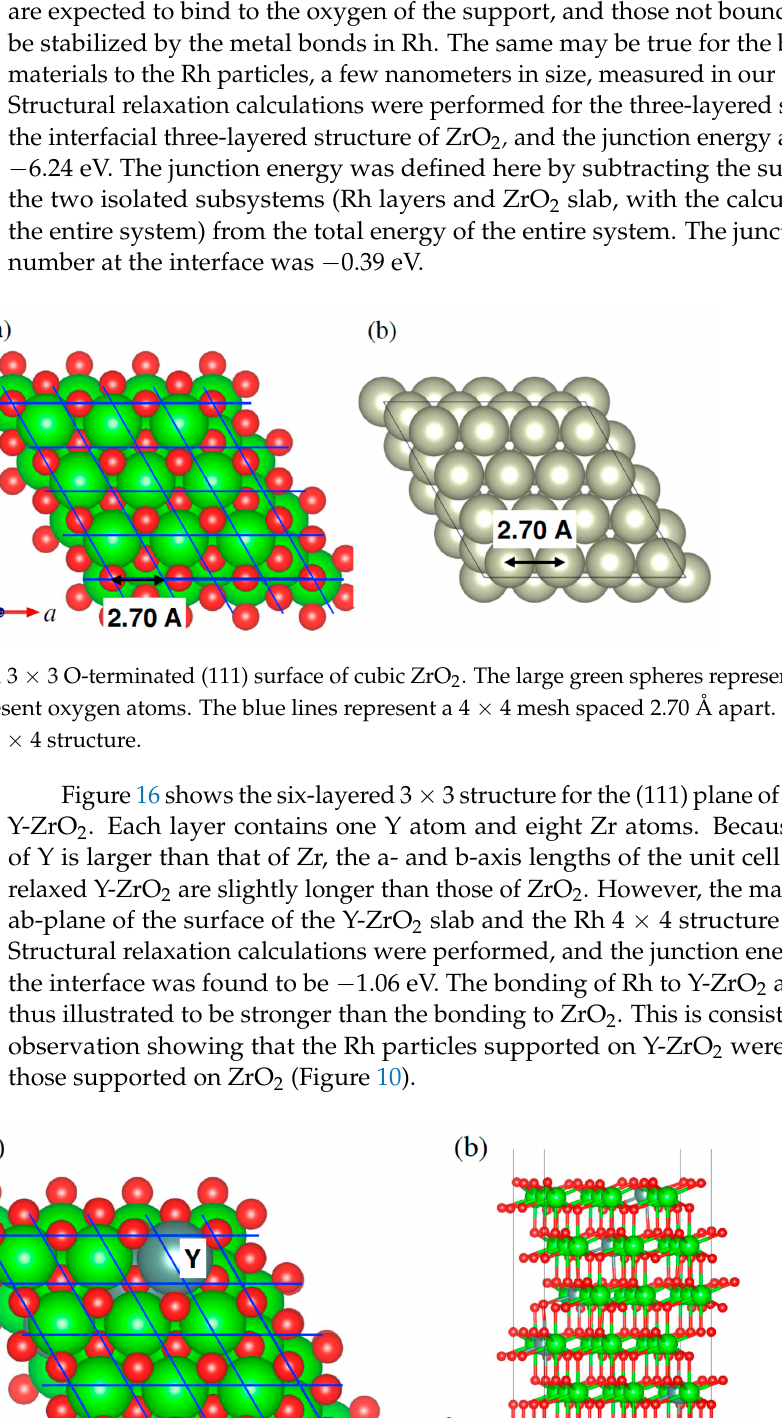
Figure 16. ( a ) Top view of a six-layered 3 × 3 O-terminated (111) surface of cubic Y-ZrO 2 . The blue lines represent a 4 × 4 mesh spaced 2.71 Å apart. ( b ) Side view of the structure. The large green spheres represent Zr atoms, the small red spheres represent oxygen atoms, and the large dark gray spheres are Y atoms. One Zr was substituted for Y in each layer of ZrO 2 .